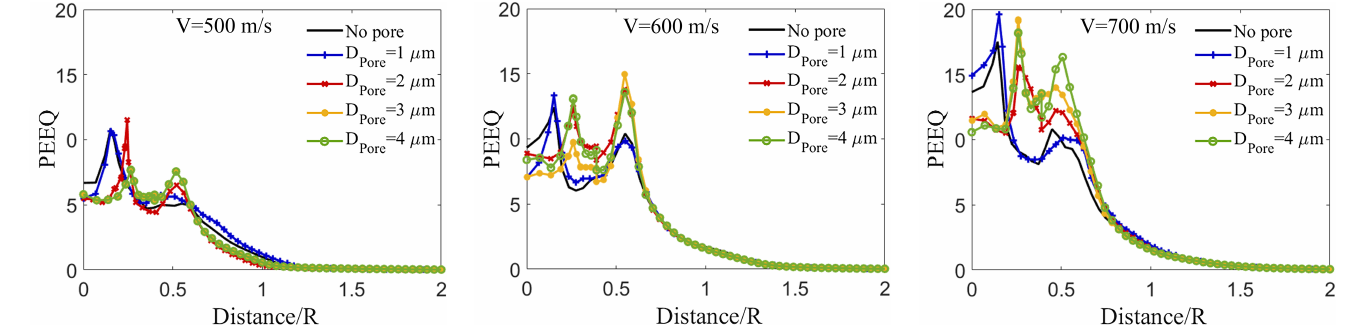
Figure 11. The time-evolved localized plastic deformation (PEEQ) over the contact-surface between the Al substrate and the B 4 C particle with D Particle = 15 µ m in the Al substrate with a pore ( D Pore = 1, 2, 3, and 4 µ m) at a depth of 0.4 D Particle at the impact velocities of 500 m/s, 600 m/s, and 700 m/s. These results are taken at 24 ns after impact for comparative purposes, with 24 ns being a time where the particle with different impact velocities no longer continues to penetrate the substrate according to Figure